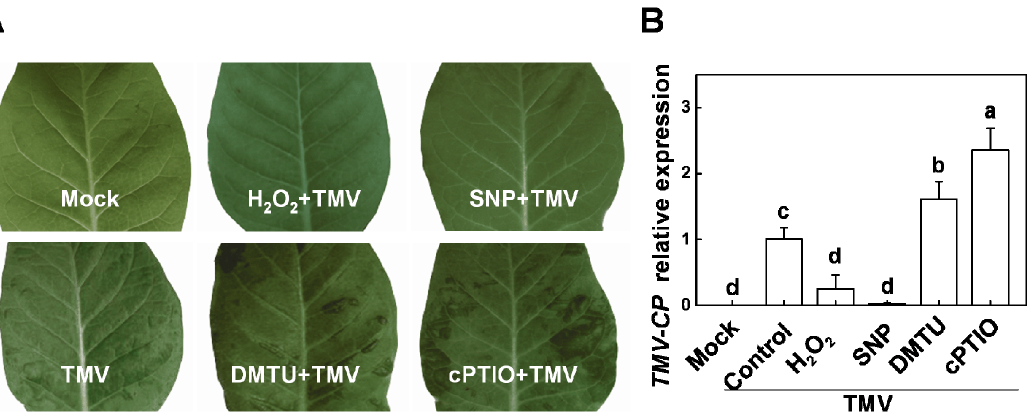
Figure 6. Effects of chemical pretreatments on TMV infection in Nicotianatabacum plants . Effects of different chemical pretreatments and TMV infection on TMV symptom development and TMV-CP transcription in the non-inoculated upper leaves of Nicotiana tabacum plants. The non- inoculated upper leaves were subjected to application of hydrogen peroxide (H 2 O 2 ) or nitric oxide (NO) chemical modulators 12 hours before TMV inoculation. A . Symptoms were photographed at 27 days after inoculation. B . TMV-CP transcript levels were analyzed by real-time reverse- transcription polymerase chain reaction at 7 days after inoculation. The results are expressed as the mean 6 SD, n = 4. The letters indicate significant differences between the treatments ( P , 0.05).